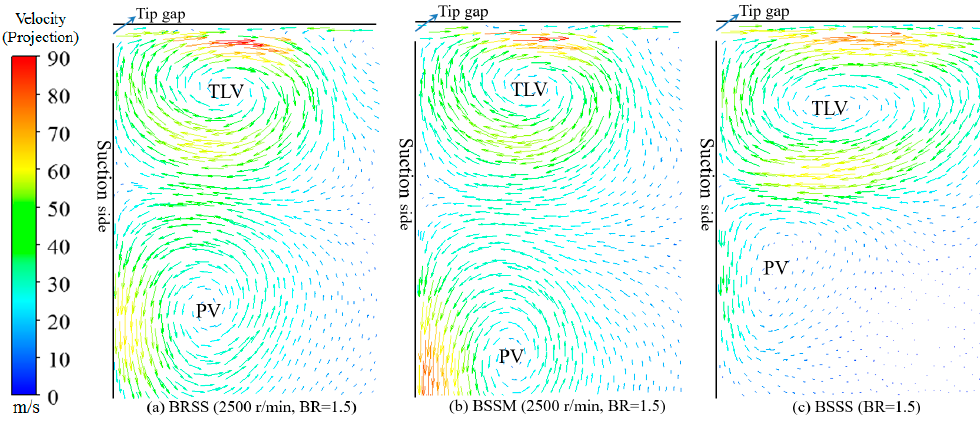
Figure 9. Velocity vectors at cut 5 at BR = 1.5: ( a ) BRSS; ( b ) BSSM; ( c ) BSSS.